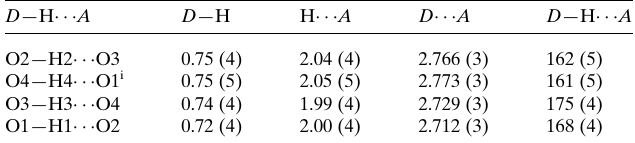
Table 3 Hydrogen-bond geometry (A˚ , (cid:2) ) for 1 .